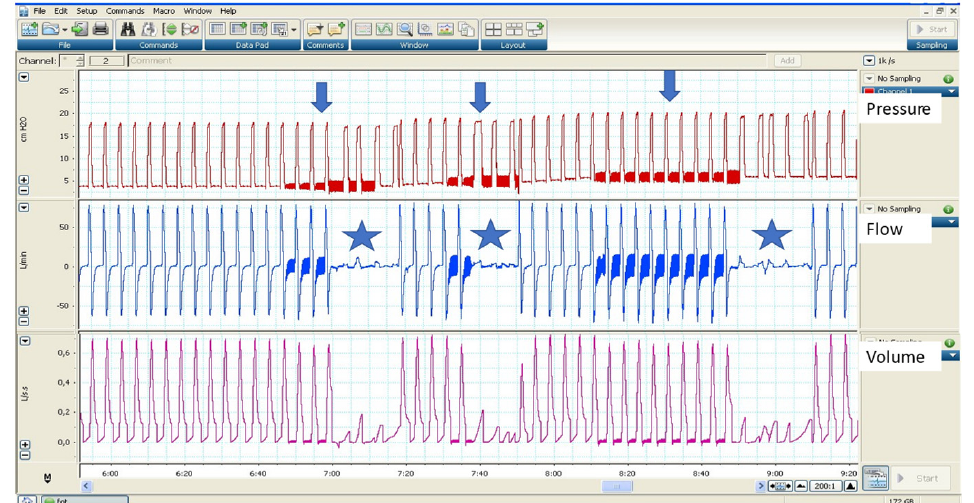
Figure 4. Example of AVAPS AE in a bench test. Observe the random intervals at which the forced oscillation technique is activated (arrows). When the system detects an obstruction (stars), there is an increase in EPAP.